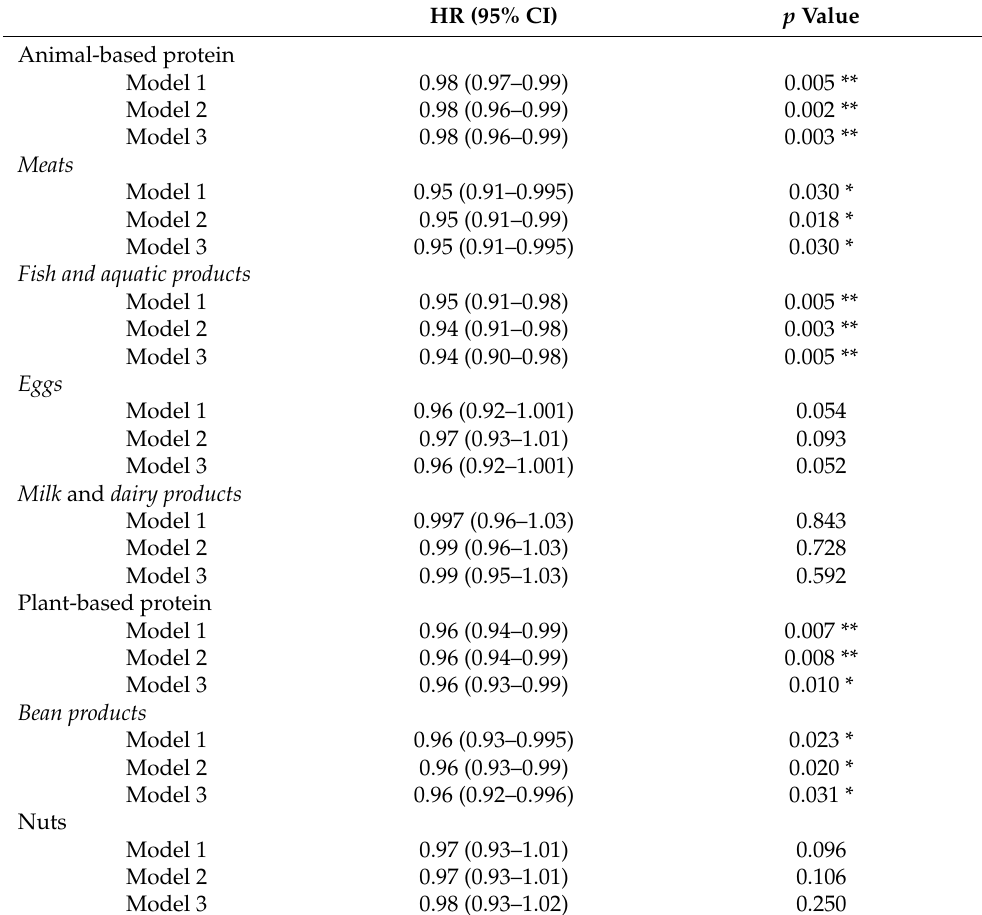
Table 3. The association between the change in different types of protein intake and cognitive